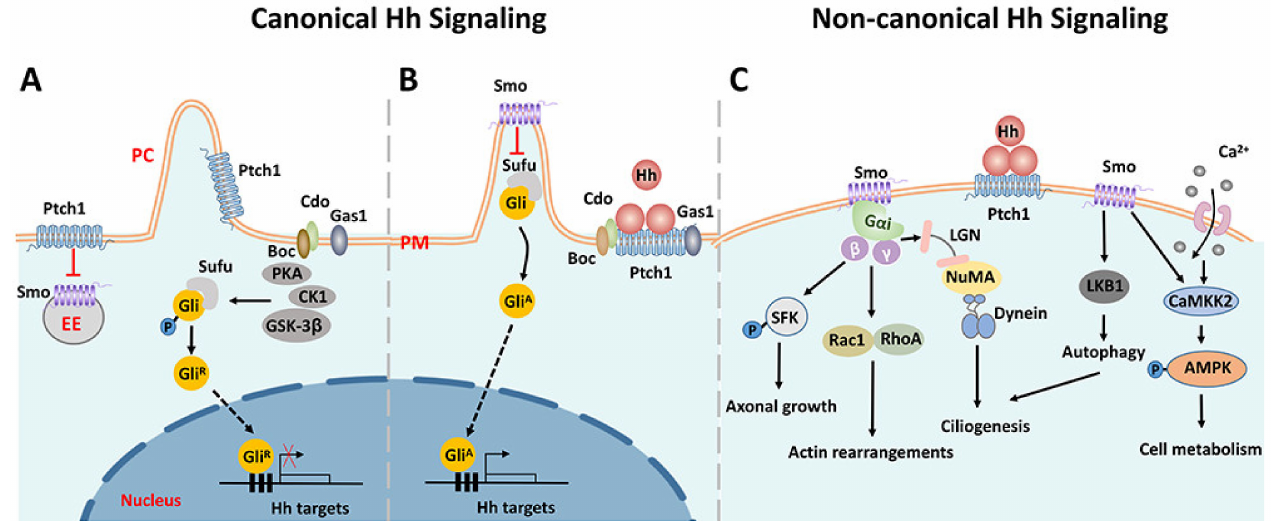
Figure 1. Schematic diagram of Smo-driven canonical and non-canonical Hh signaling pathways. ( A ) In the canonical Hh signaling, when Hh ligands are absent, Ptch1 exerts a repressive activity on Smo. Gli factors are sequestered by Sufu and phosphorylated by PKA, CK1, and GSK-3 β , and then cleaved by post-translational proteolytic processing. The truncated Gli factors translocate into the nucleus and repress the transcription of downstream genes. ( B ) Upon Hh binding to Ptch1, the repression of Smo is relieved and Smo accumulates in the primary cilium, inhibiting the sequestration and phosphorylation of Gli factors. The full-length Gli factors then translocate into the nucleus and ultimately activate the transcription of downstream genes. ( C ) Representative non-canonical Hh signaling pathways dependent on Smo. Smo can activate several downstream effectors involved in various biological processes. PM: plasma membrane. PC: primary cilium. EE: early endosome. ER: endoplasmic